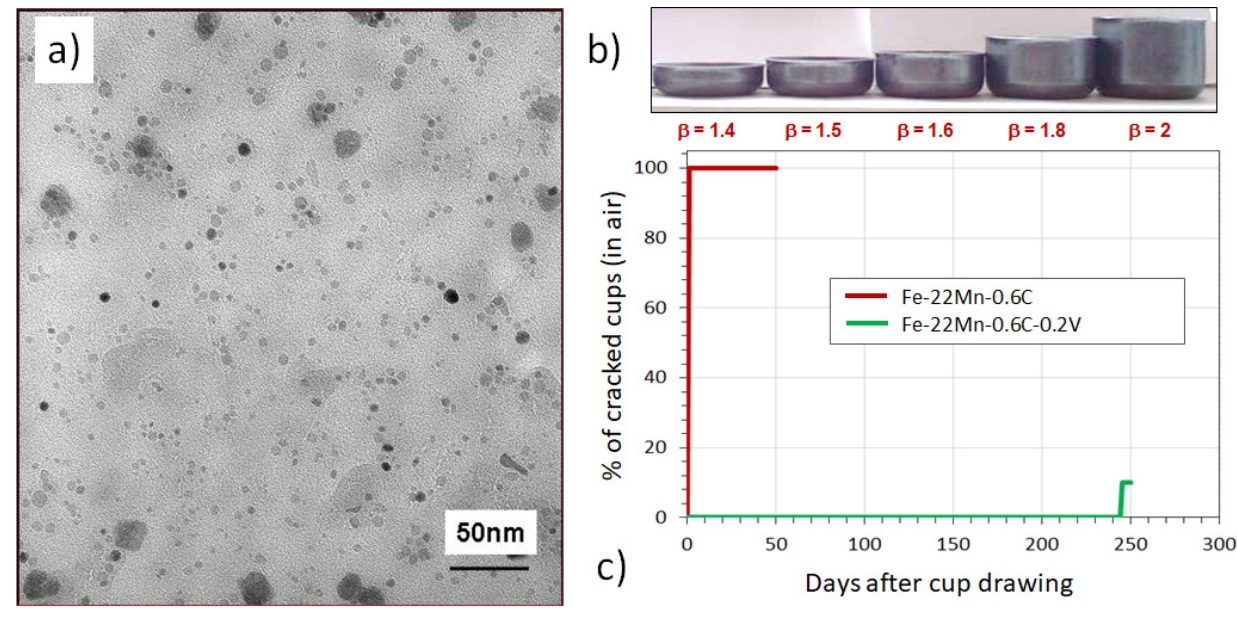
Figure 1. ( a ) TEM replica of V(C,N) in cold-rolled Fe-0.6C-22Mn-0.2V-0.01N; ( b ) deep-drawn cups used for HE testing; and ( c ) the effect on crack formation in fully drawn cups [17].